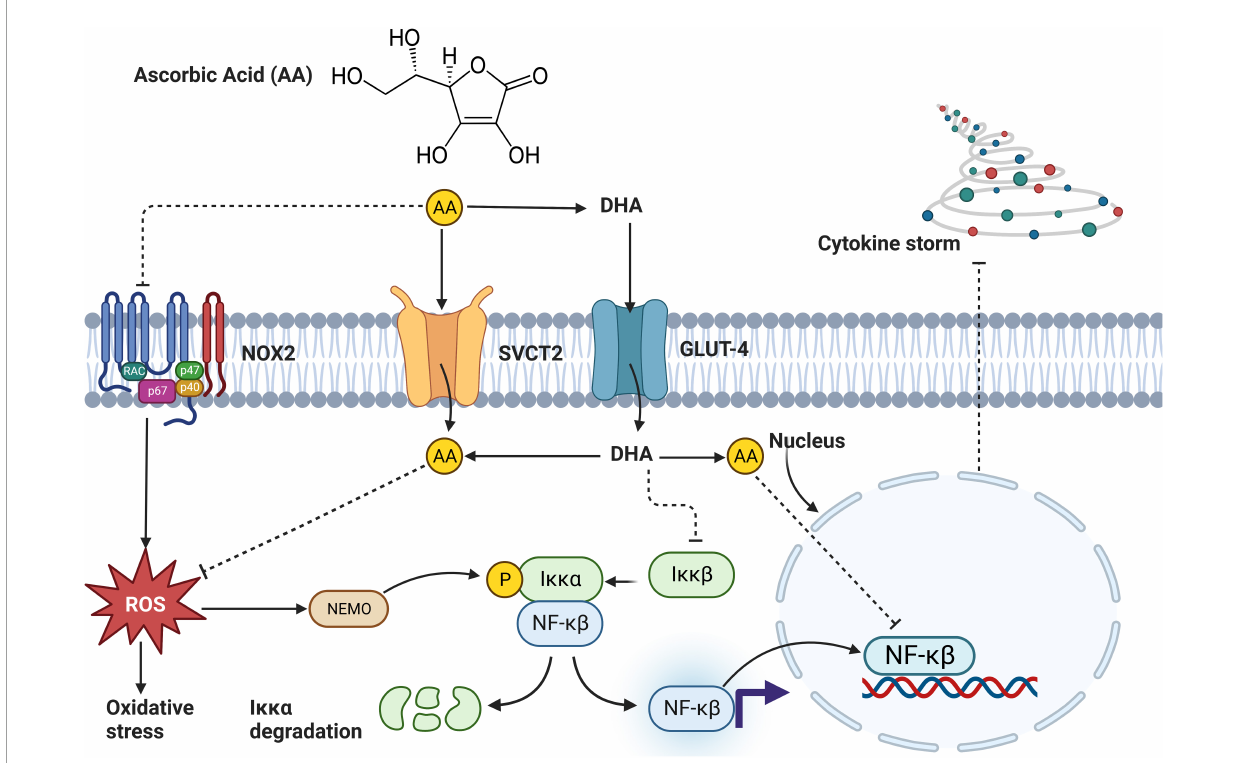
FIGURE5 An overview mechanism by which ascorbic acid (AA) found in Corchorus olitorius reduces inflammation. AA enters the cell through sodium-vitamin C cotransporter 2 (SVCT2) or indirectly as dehydroascorbic acid (DHA). In the cell, DHA is converted to AA and directly inhibits activation of NF- κβ or through a series of pathways involving suppressing reactive oxygen species (ROS) generation and slowing down oxidative stress. Alternatively, AA blocks NADPH oxidase (NOX2) activation, further inhibiting ROS generation, and oxidative stress. Inhibition of NF- κβ directly inhibits inflammation